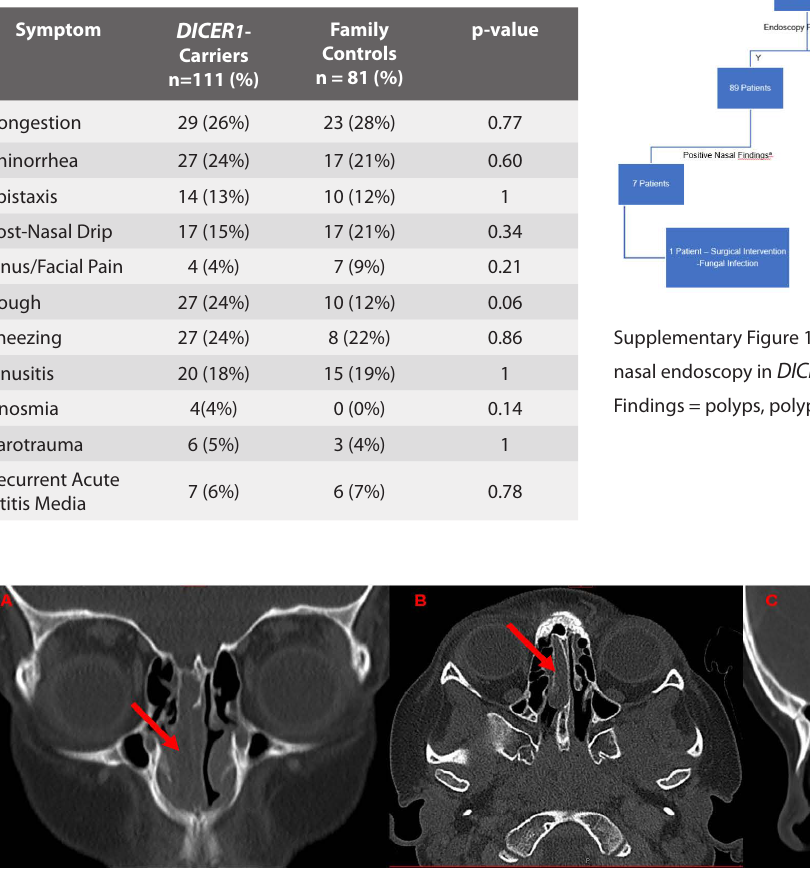
Supplementary Figure 2. Sinus CT - A: (coronal view) An opacified mass filling the entire right nasal cavity and extending up to the fovea ethmoidalis and cribriform. The crista galli of the cribriform deviated to the left side. B: (axial view) A nasal expansile mass filling the right medial nasal cavity. C: (sagittal view) Right nasal mass extending up to the fovea ethmoidalis (case #64 in Table 2).